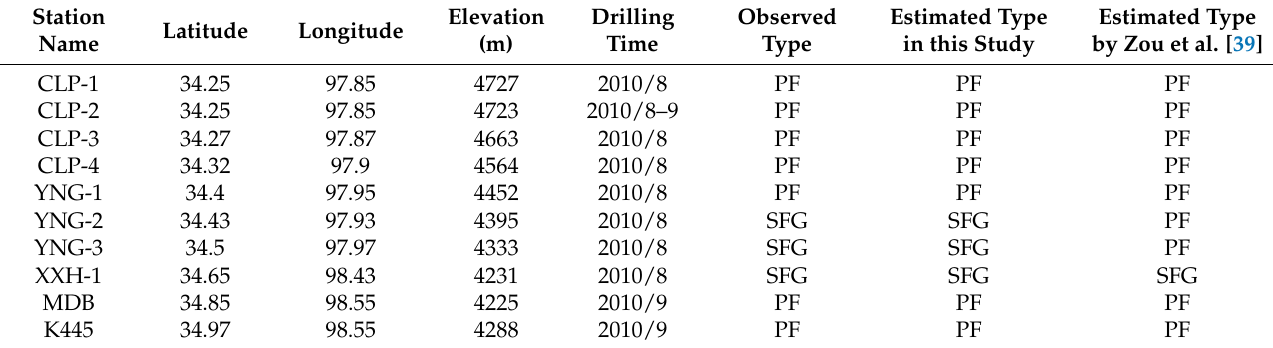
Table 2. Validation of the frozen soil types estimated by the TTOP model at 10 boreholes.